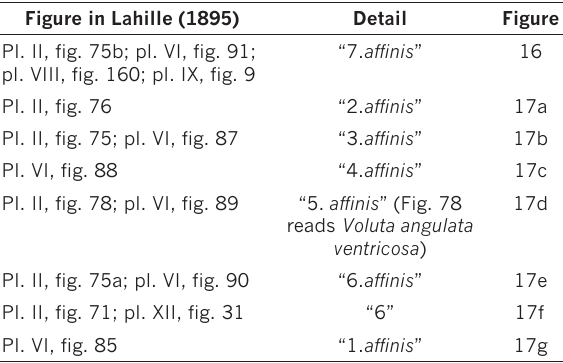
Table 5. Voluta angulata affinis specimens figured by Lahille (1895) with the details of the inscriptions on their shells and figures